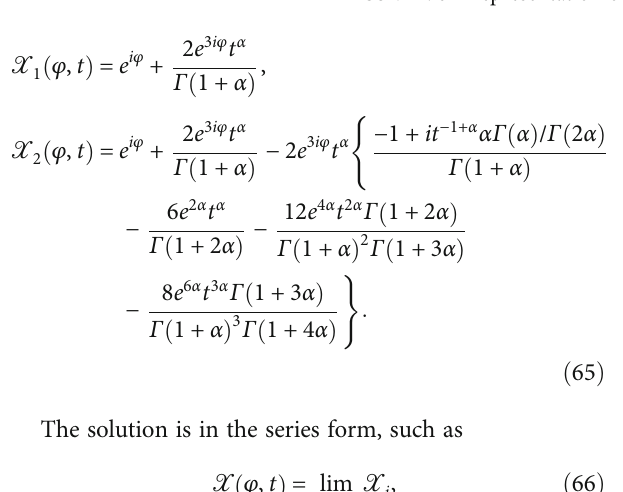
Figure 4: 3D representation of X for α = 0 : 8 (a) and α = 1